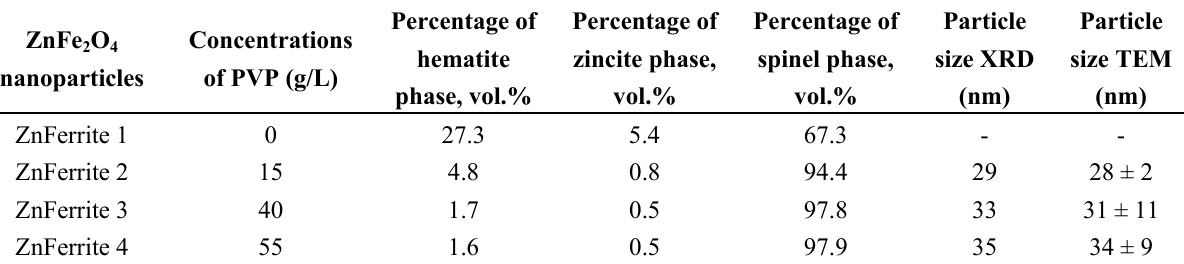
Table 1. Phase composition and average particle size (nm) of ZnFe with various of concentrations of poly(vinyl pyrrolidone) (PVP) determined by X-ray diffraction (XRD) and transmission electron microscopy (TEM) techniques calcined at 873